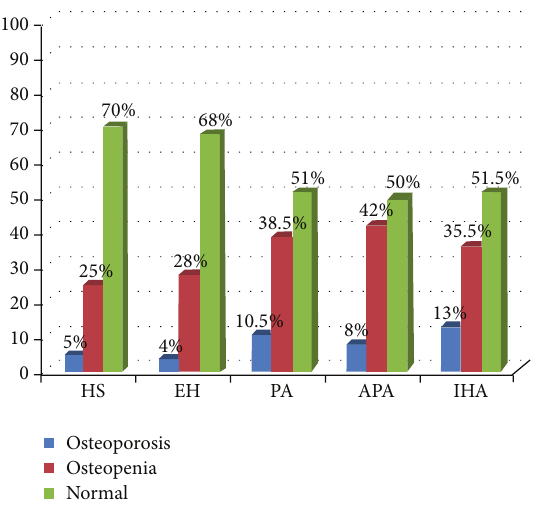
Figure 2: Prevalence of osteoporosis in in all subjects enrolled. HS: healthy subjects; EH: essential arterial hypertension; PA: primary aldosteronism; APA: aldosterone-producing adrenal ade- noma; IHA: idiopathic bilateral